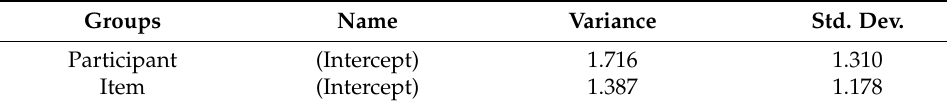
Table A14. English T2 random effects.